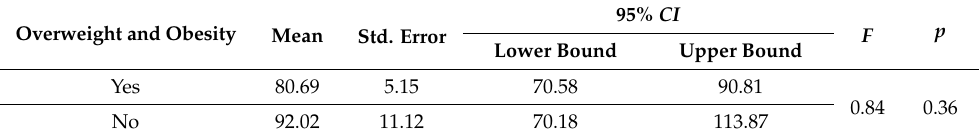
Table A4. Comparison of ST between overweight and obese and normal children and adolescents.